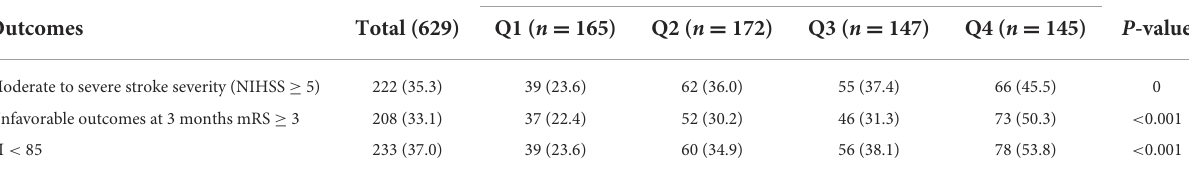
TABLE 2 Comparison of stroke severity and functional outcomes according to quartiles of